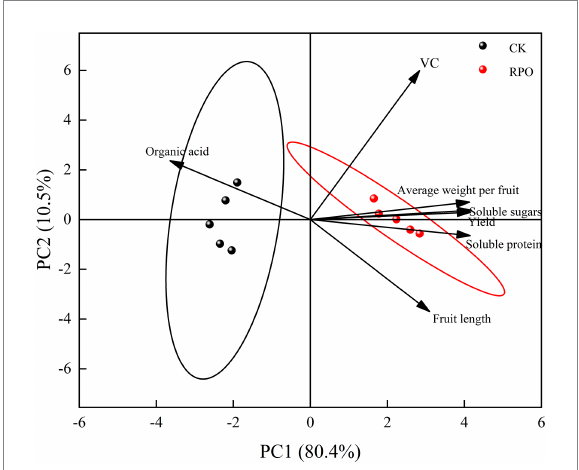
FIGURE 4 Principal component analysis results of RPO on sweet pepper quality and yield.